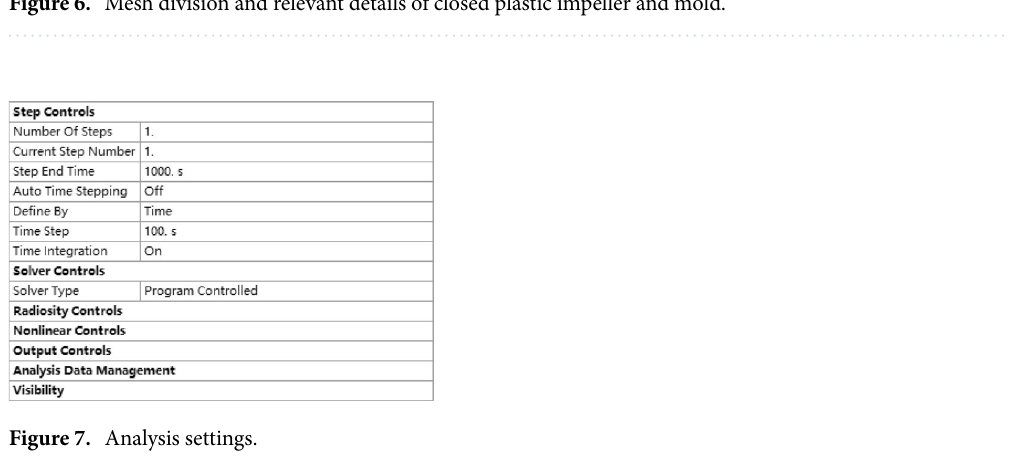
Figure 6. Mesh division and relevant details of closed plastic impeller and mold.